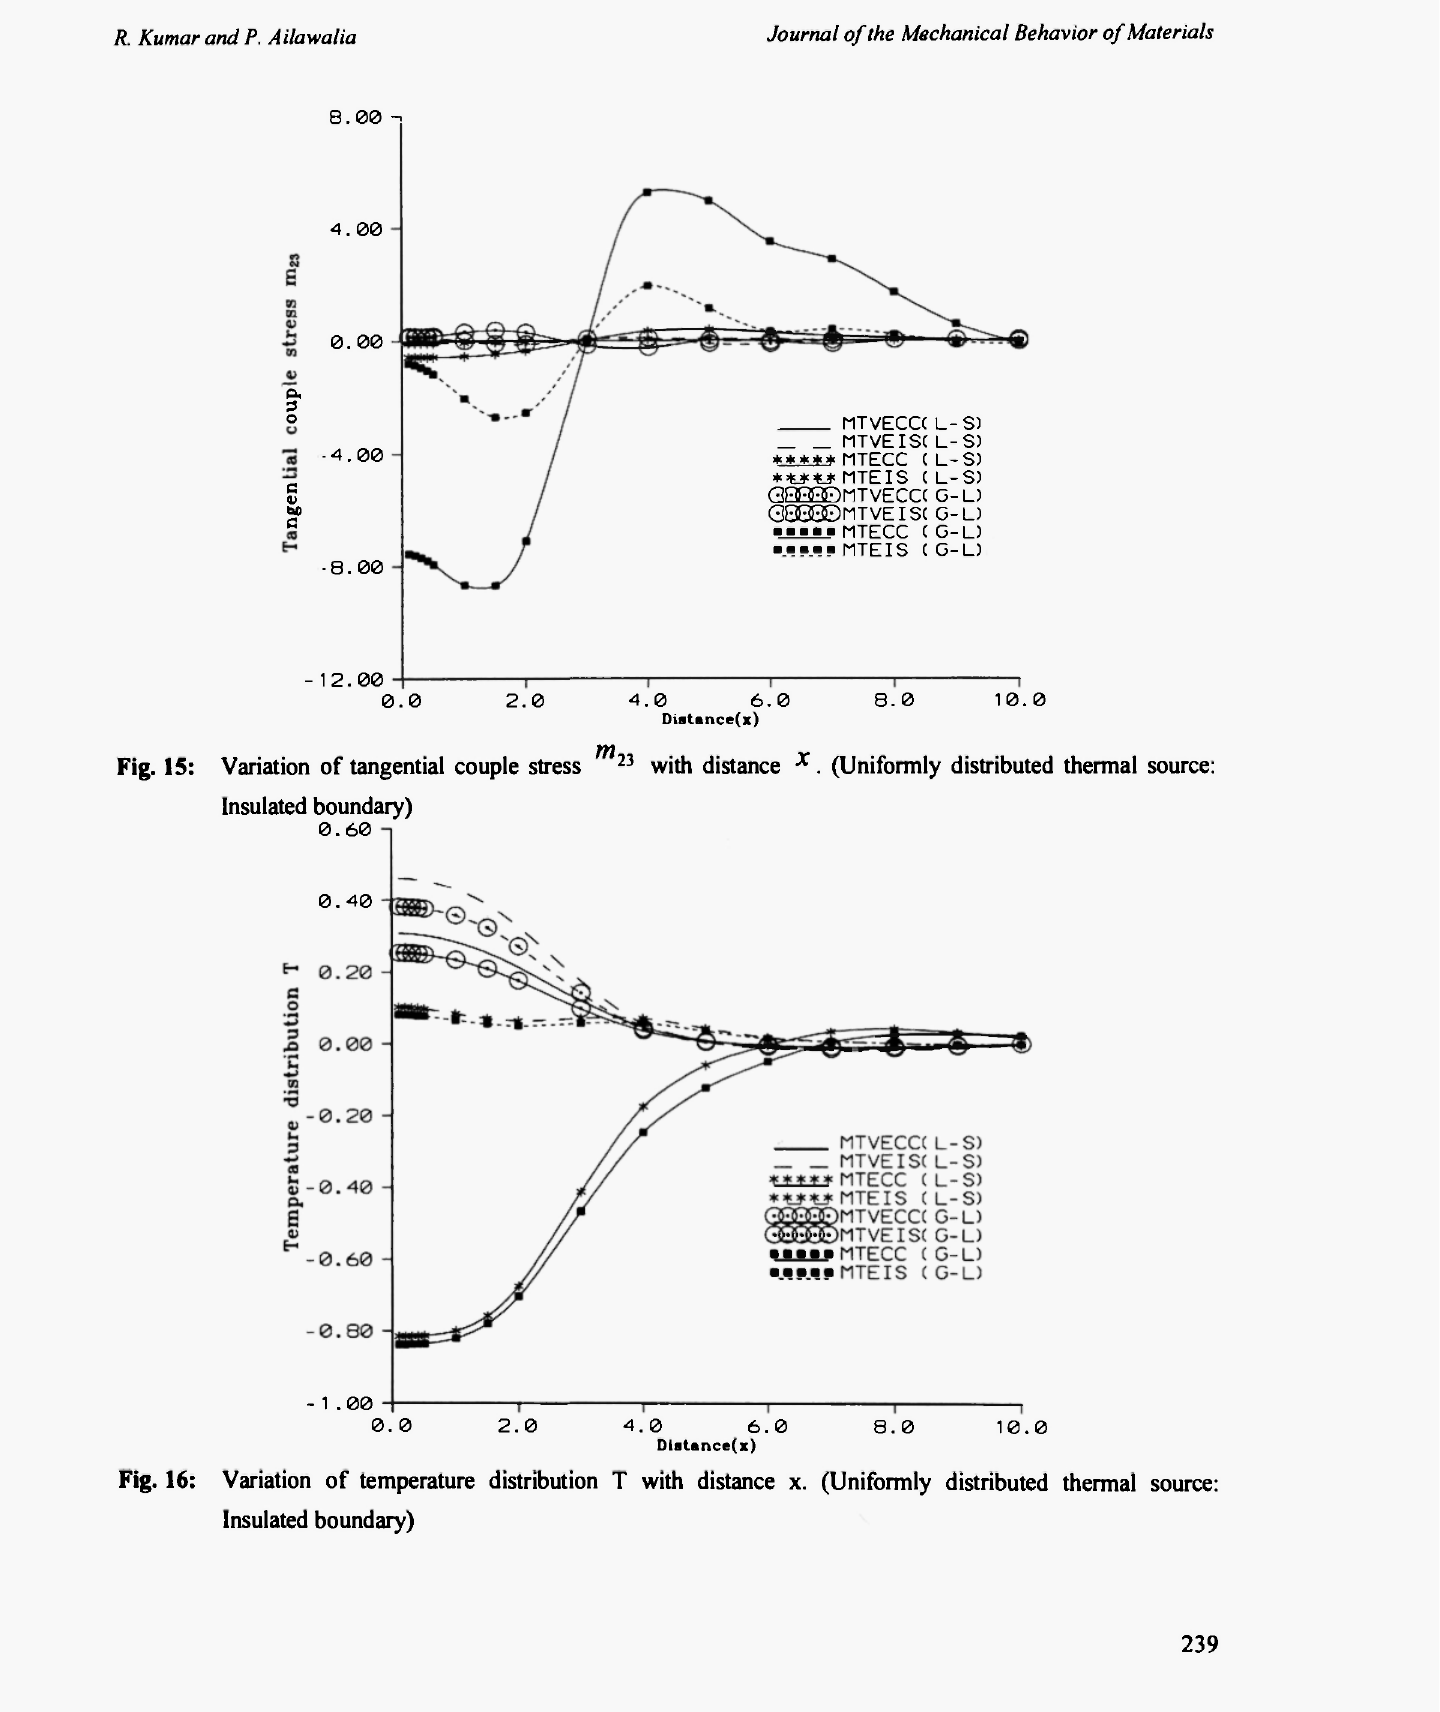
Fig. 16: Variation of temperature distribution Τ with distance x. (Uniformly distributed thermal source: Insulated